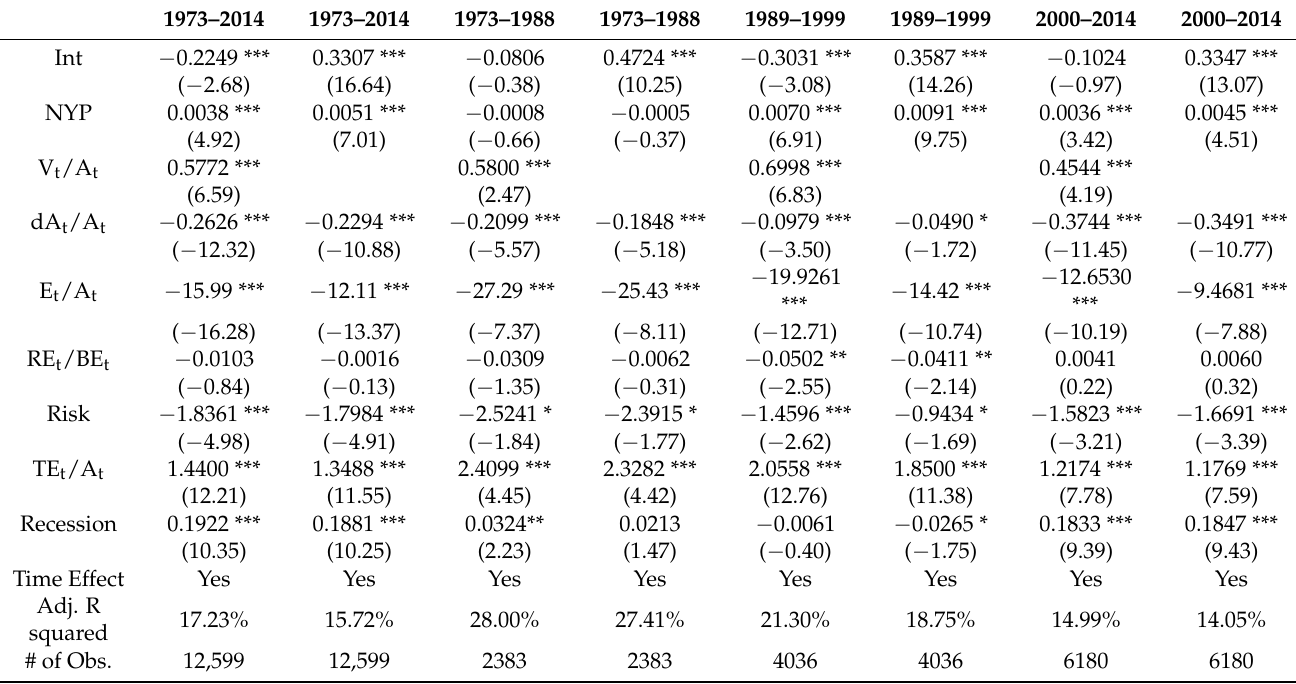
Table 7. OLS (ordinary least square) regressions of the determinants of the payout ratio. This table provides results of OLS regressions of the determinants of the payout ratio. The dependent variable equals total dividend over income (following Farre-Mensa et al. 2014). The independent variables are: Profitability (E t /A t ), growth rate of assets (dA t /A t ), percentile of market capitalization in NYSE firms (NYP), and market-to-book ratio (V t /A t ). Other variables from the literature are also added. Standard errors are clustered at the firm level. T-statistics are reported in the parentheses. ***, **, and * indicate statistical significance at the 1%, 5%, and 10% level,